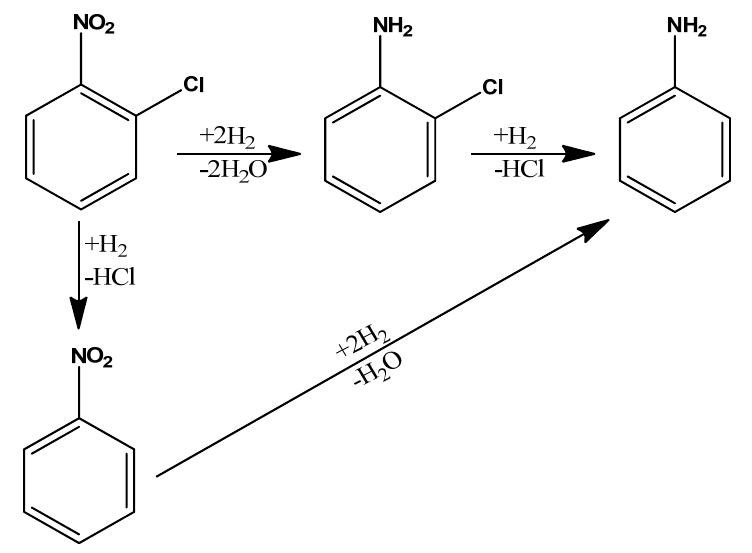
Figure 2. Reaction scheme for the o-CNB hydrogenation.